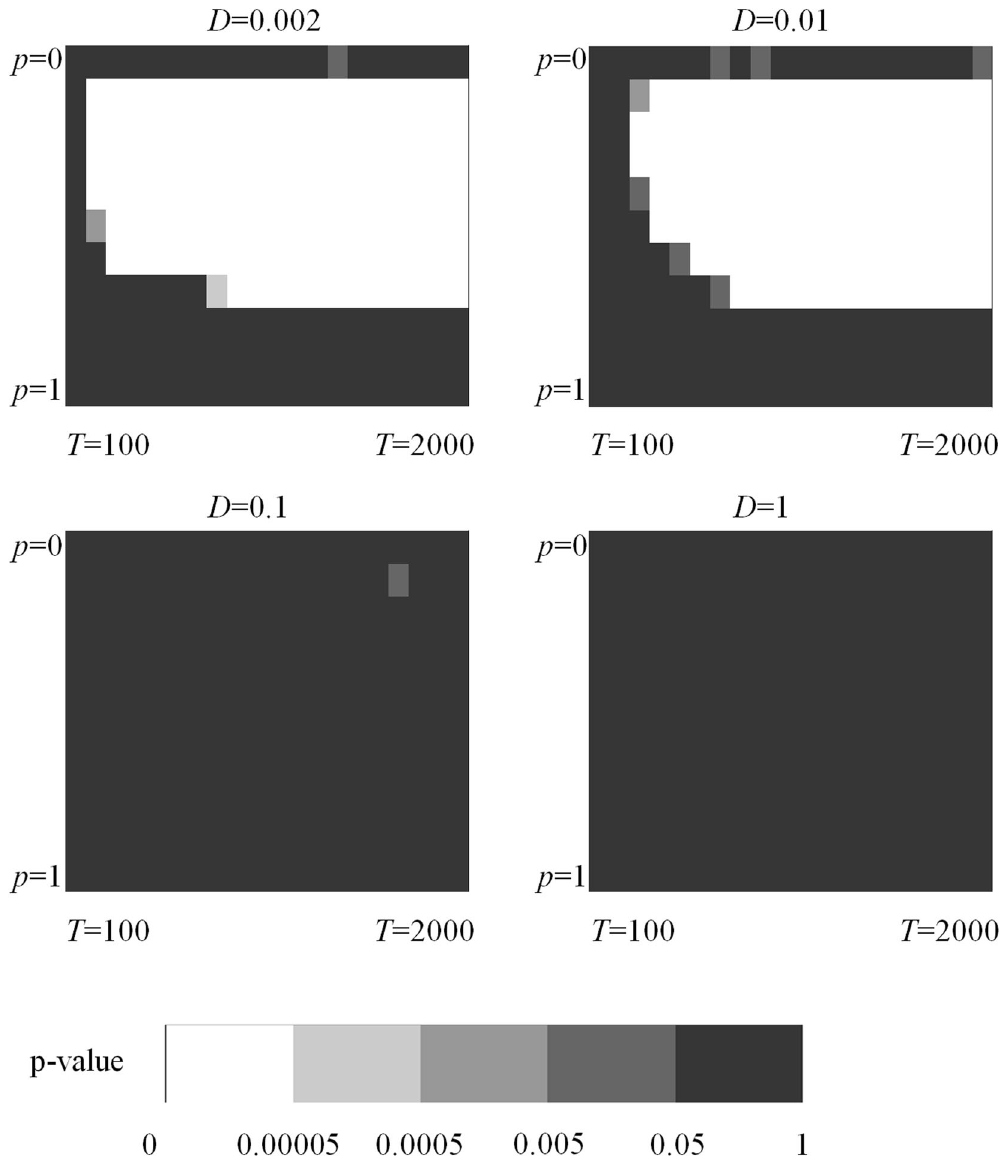
Fig. 4 The outcome of competition between the solitary-type strategy and the social-type strategy in the T - p parameter space for various values of D . The non-black squares indicate that social-type strategy outcompetes the solitary-type strategy more frequently than what is expected by random chance (i.e., when the simulation model is compared with the null model), with the brightness indicating the statistical signi fi cance of the result. A black square indicates that the frequency of the social-type strategy outcompeting the solitary-type strategy is not signi fi cantly different from what is expected by random chance at the 5% signi fi cance level. Values for other parameters are: M = 1000, N = 20, Q = 1, S = 1, E =